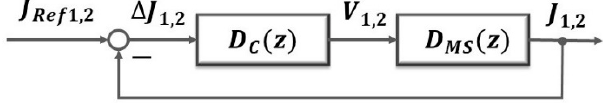
Figure 2. Modal control loop for modal currents 𝐽 (cid:2869),(cid:2870) .